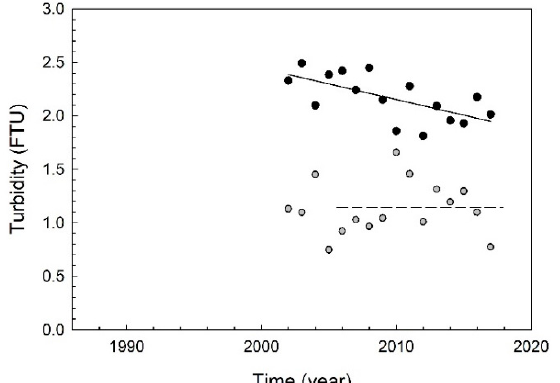
Figure 5. Temporal evolution of the turbidity of the surface layer of Lake Banyoles. Solid black symbols represent the mean turbidity during the December, January and February (DJF) period and solid grey symbols represent the mean turbidity during the July, August and September (JAS) period.